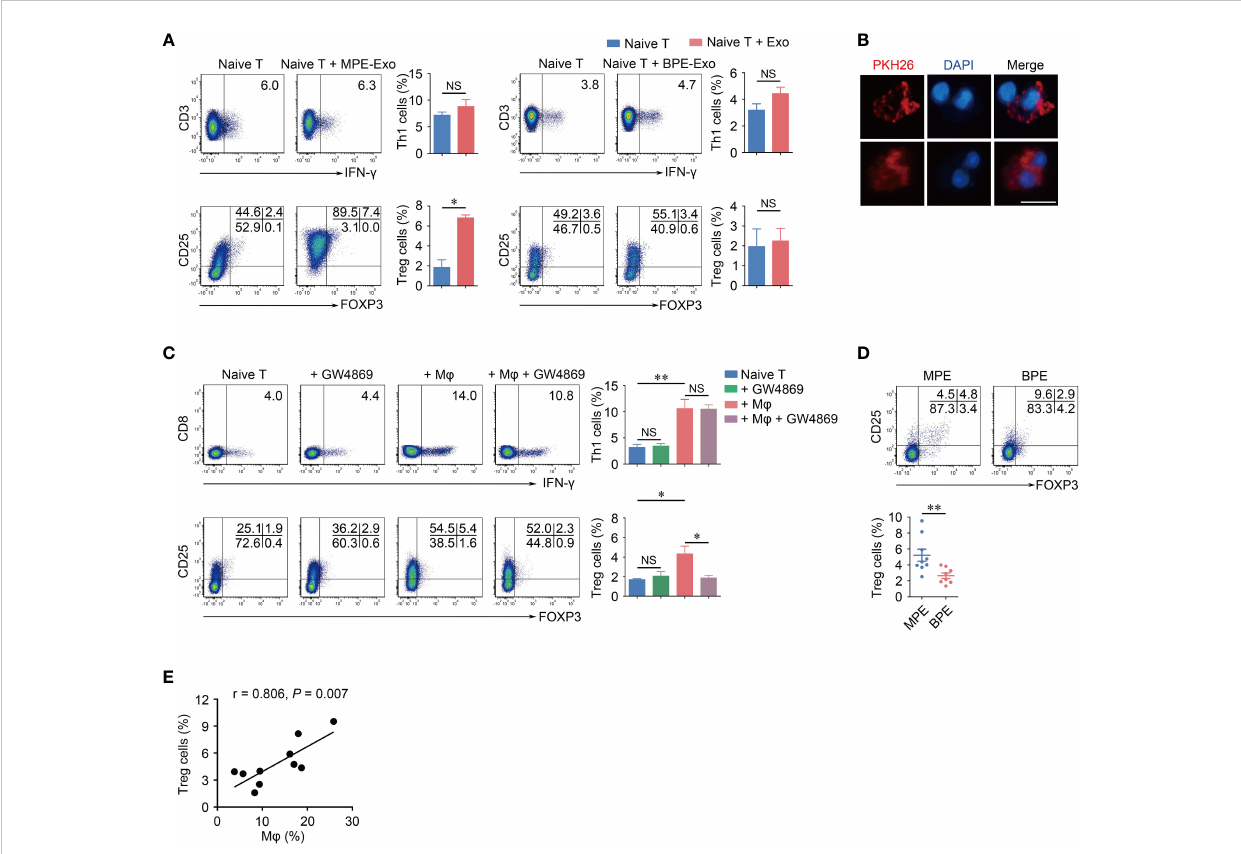
FIGURE 4 Exosomes from M j s in MPE promote Treg cells differentiation in vitro . (A) Naïve CD4 + T cells were cocultured in the presence of control or puri fi ed exosomes from MPE M j s (MPE-Exo) or BPE M j s (BPE-Exo) under stimulation with anti-CD3 and anti-CD28 mAbs for 3 days. The representative fl ow cytometry plots of Th1 cells and Treg cells are shown from three independent experiments. Comparisons of percentages of Th1 cells and Treg cells are shown. (B) Immuno fl uorescence images of exosomes (red) taken up by CD4 + T cells after treatment with PKH26-labeled exosomes. 400 × magni fi cation; Scale bar, 10 m m. (C) Naïve CD4 + T cells were cocultured with M j s treated with GW4869 (10 m M) or control in the presence of anti- CD3 and anti-CD28 mAbs for 5 days. The representative fl ow cytometry plots of Th1 cells and Treg cells are shown from one of three